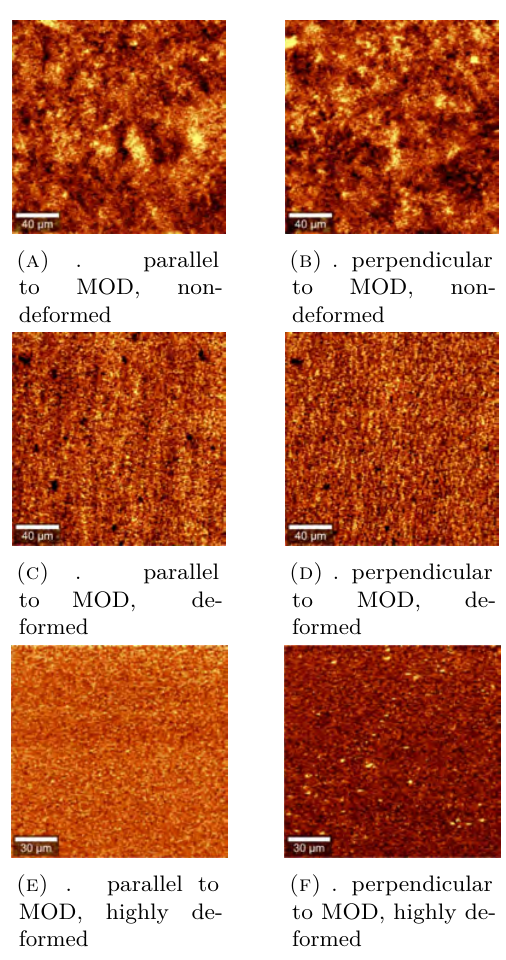
Figure 6. orientation distribution of PP samples calculated from confocal Raman